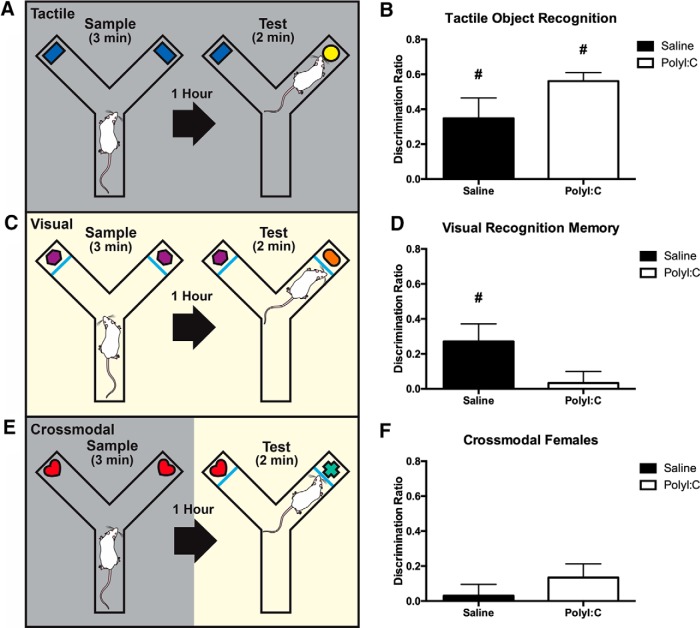
A, The Y-maze assembled to conduct the tactile phase in red light conditions where the rat is able to explore objects via touch. B, both groups of offspring display robust novelty preference in the tactile phase with novel object exploration significantly greater than chance levels. C, The Y-maze assembled for the visual phase which is conducted in white light conditions with the addition of a clear, Plexiglas window to prevent tactile exploration of the objects, limiting the rats to visual observation. D, Saline offspring demonstrated visual memory with novel object exploration significantly greater than chance but polyI:C offspring did not perform above chance levels. E, The Y-maze assembled for the crossmodal phase which has a tactile sample phase and visual test phase. F, both groups failed to display crossmodal recognition memory as novel object exploration was equal to chance; # indicates significant difference from chance exploration (DR = 0, p < 0.05) in a single sample t test. Schematic has been published previously (Lins et al., 2018; Paylor et al., 2018).